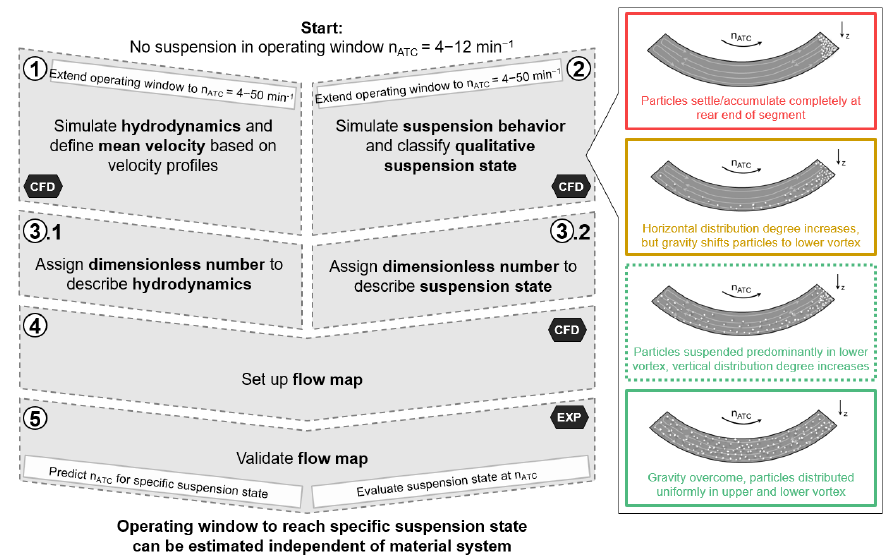
Figure 7. Five-step road map to estimate suspension behavior. The individual steps are carried out by computational fluid dynamics simulations (CFD) or experimentally